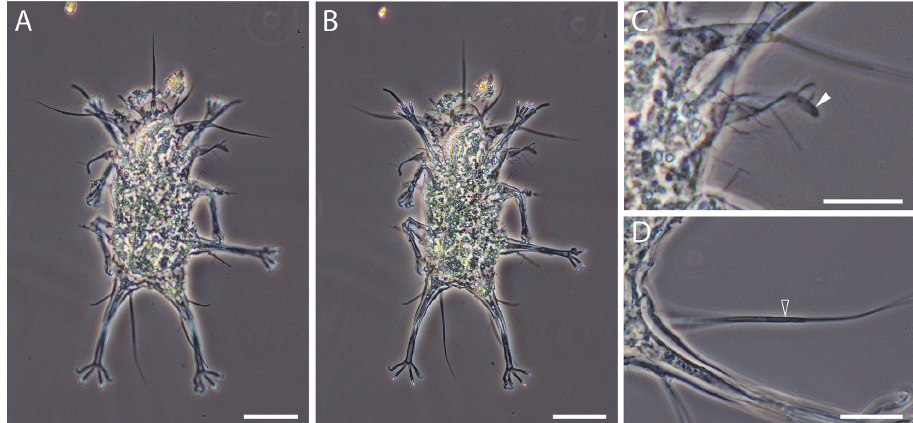
Figure 5. Phase contrast micrograph of Halechiniscus churakaagii sp. n., holotype KUZ Z710. A dorsal view, scale bar = 50 μm B ventral view, scale bar = 50 μm C scapular process (white arrowhead), scale bar = 10 μm D cirrus E with dark region (white, hollow arrowhead), scale bar = 20